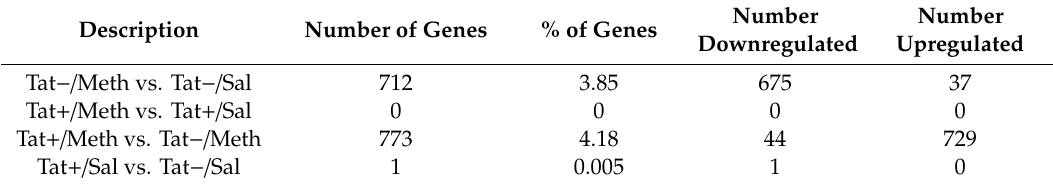
Table 1. Number of signatures derived from group comparisons for gene expression in brains from Tat + and Tat − mice treated with Meth or with saline, with FDR_BH < 0.05, and absolute fold change > 2.0 upon assigned